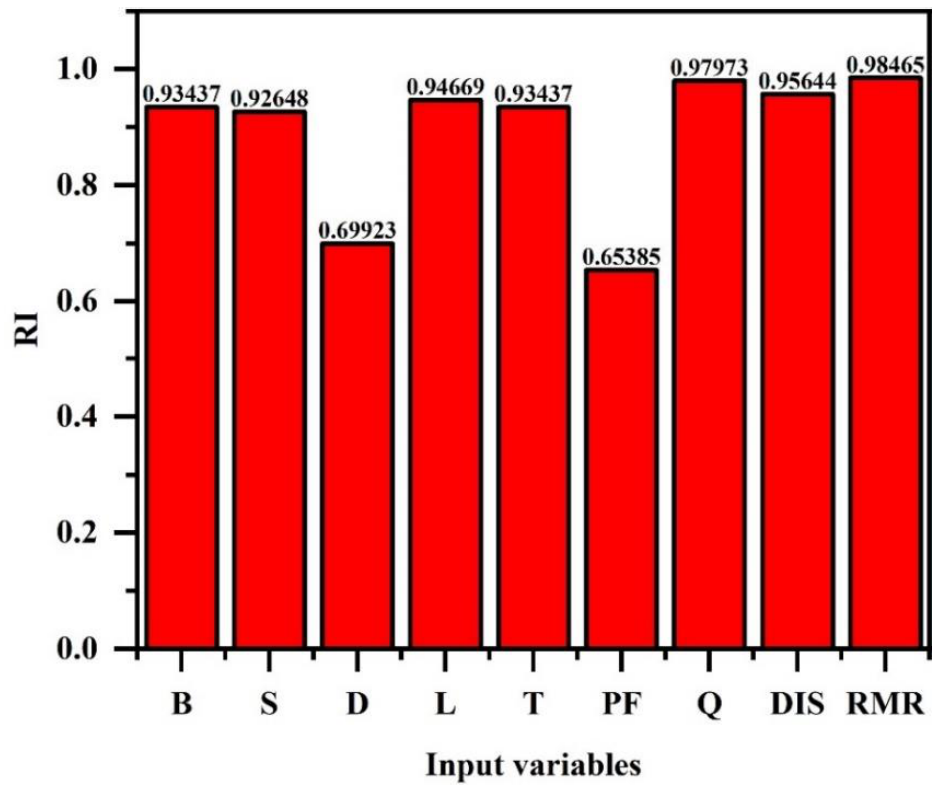
Figure 10. Relevance importance of model input parameters on the AOp.